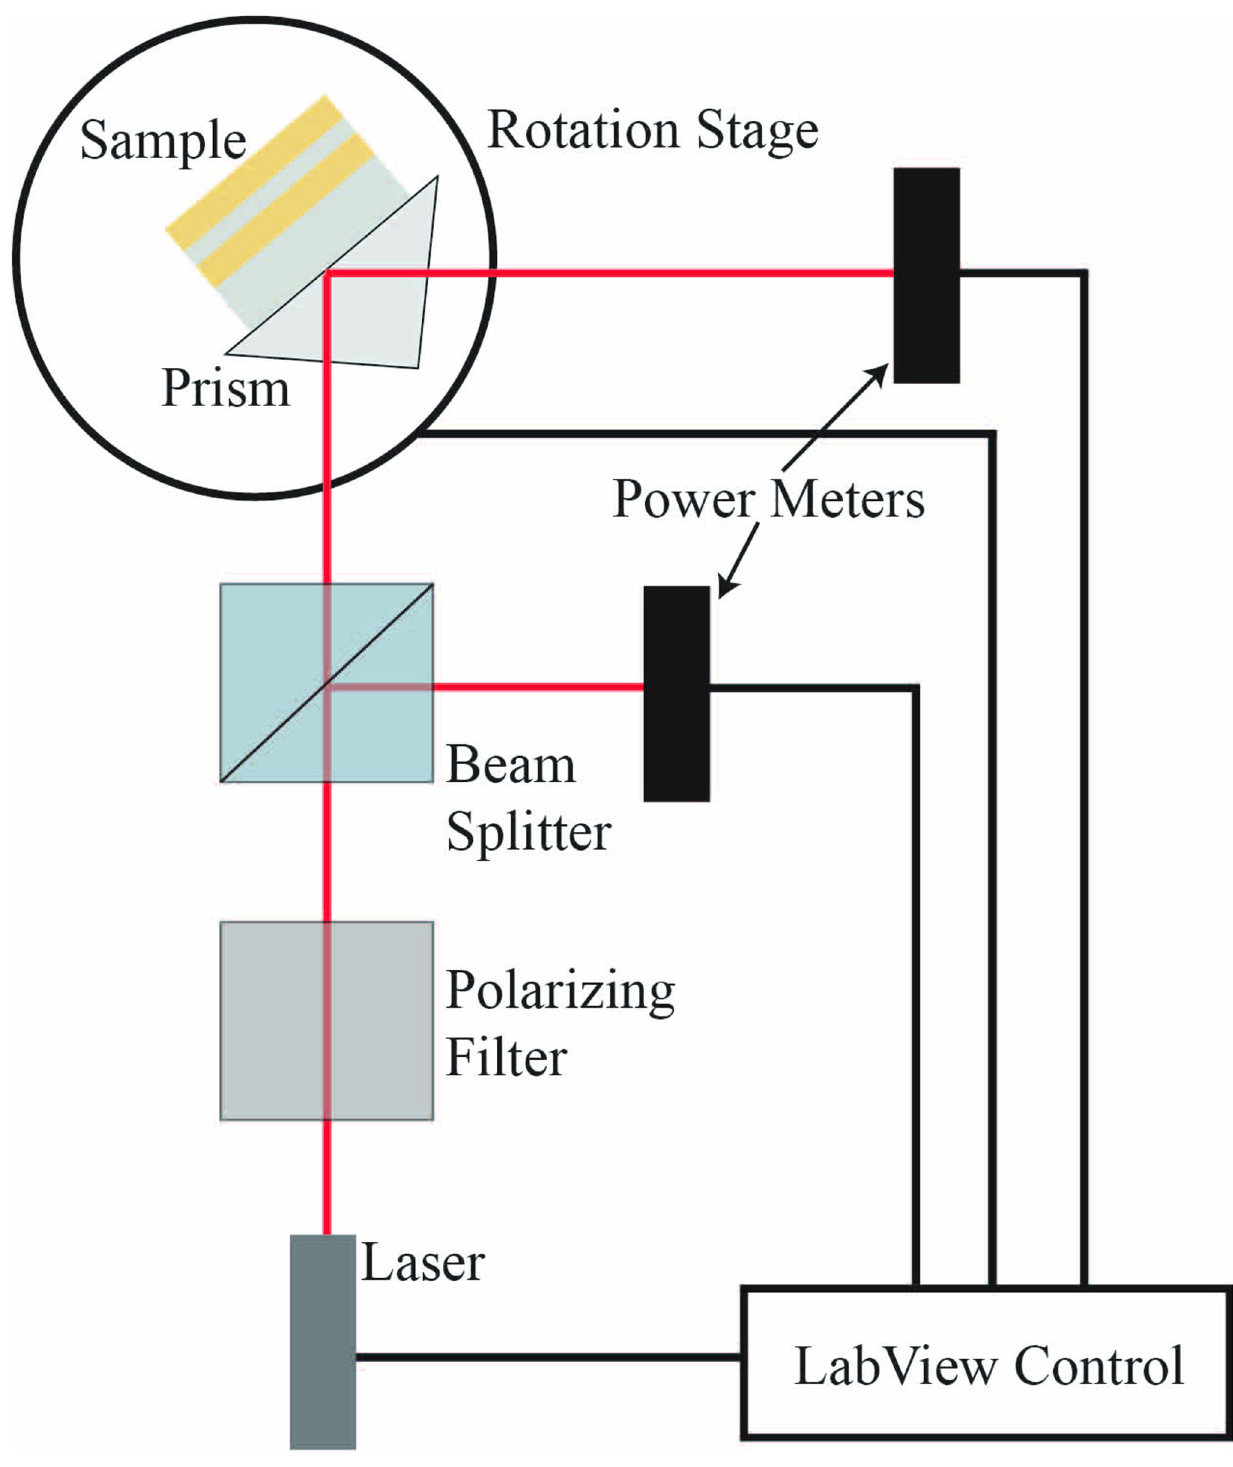
Fig 4. Schematic of the attenuated total reflectance experimental setup used in this study.